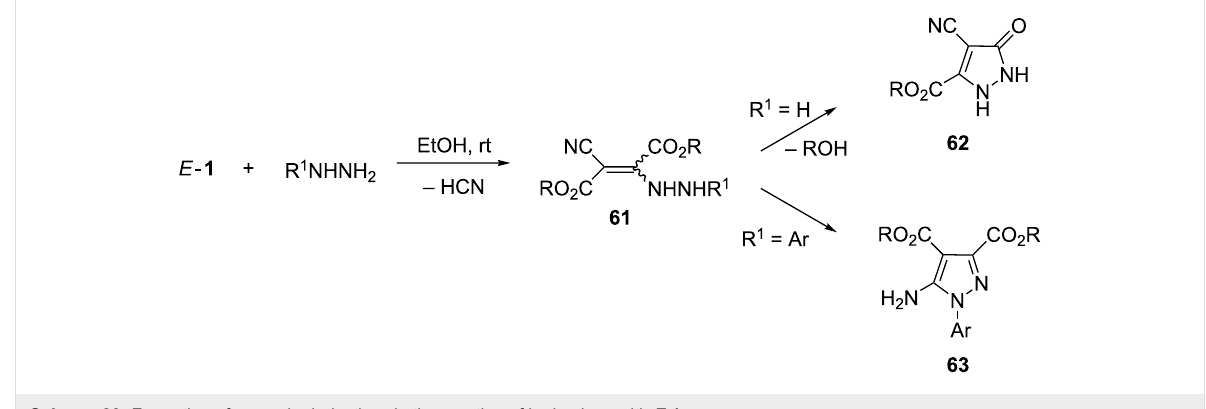
Scheme 20: Formation of pyrazole derivatives in the reaction of hydrazines with E - 1 .